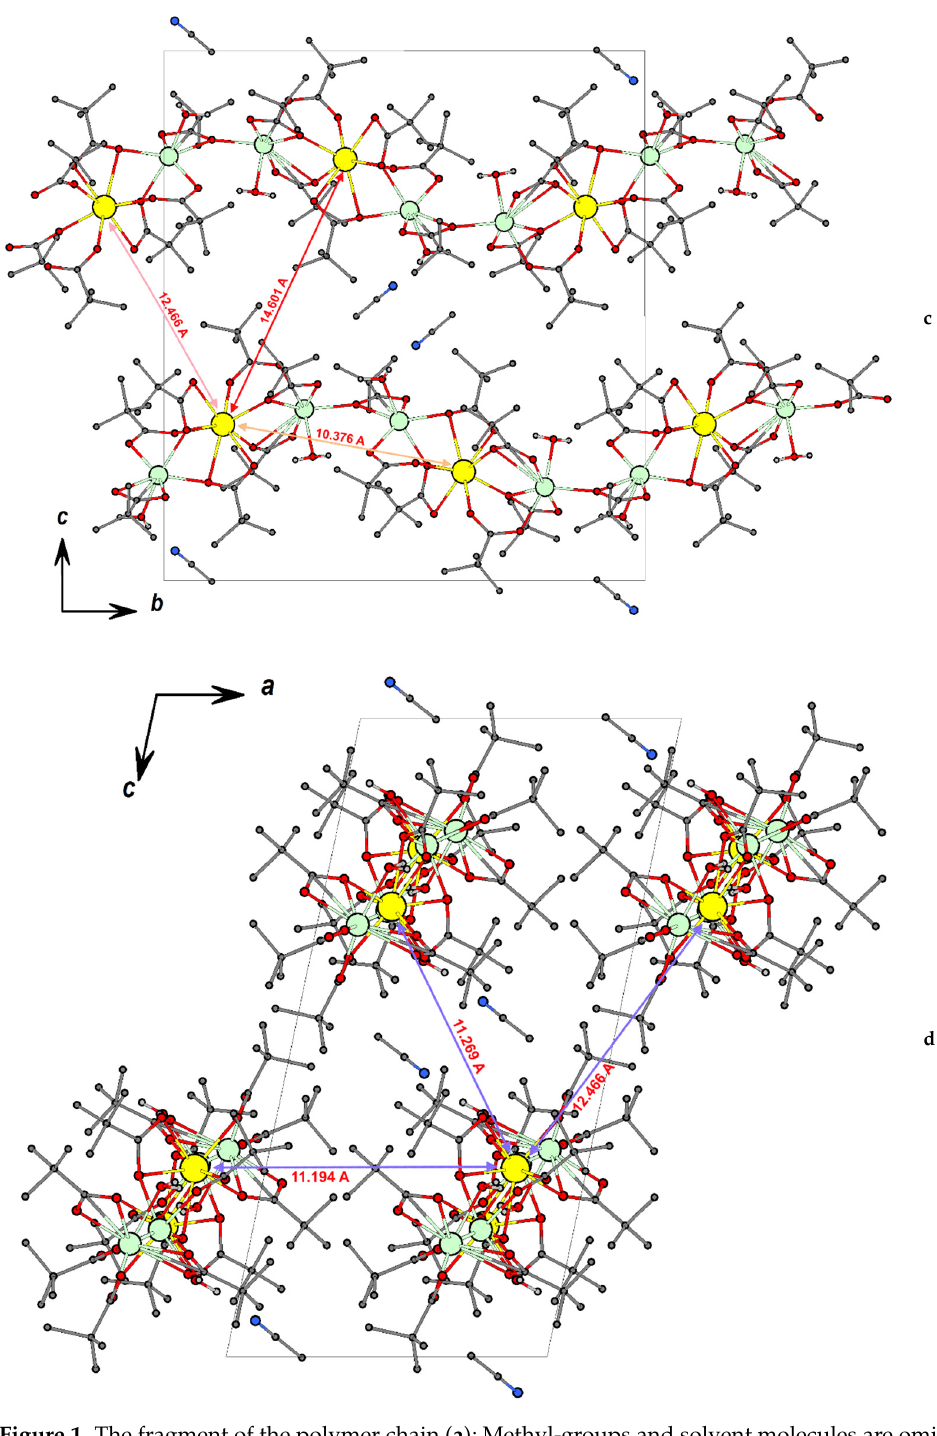
Figure 1. The fragment of the polymer chain ( a ); Methyl-groups and solvent molecules are omitted, the dashed line corresponds to H-bond, atom index: 1/2 − x , 1/2 + y , 1/2 − z (A); 1/2 − x , − 1/2 + y , 1/2 − z (B)), the EuO 8 polyhedron ( b ) and crystal packing ( c , d ); H atoms at carbon atoms are omitted, the interatomic distances Eu ··· Eu are indicated by arrows) of 2 .